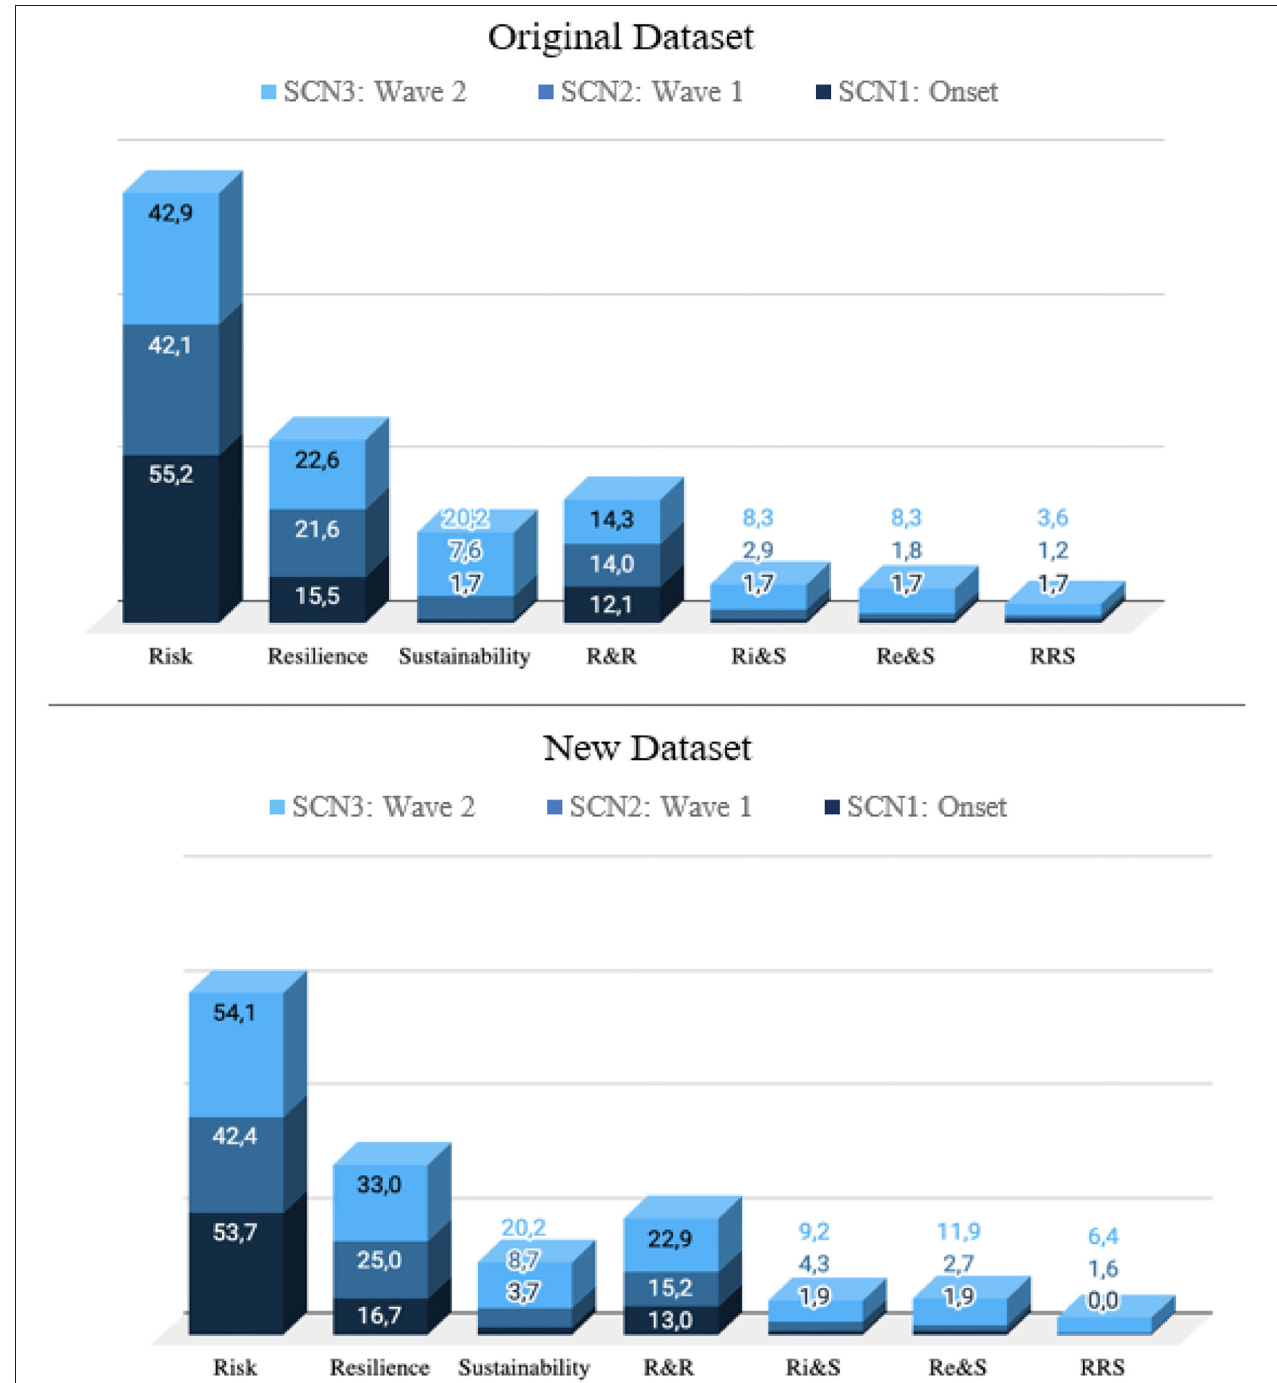
FIGURE 12 | Distribution RRS per time frame of SCN in % for original (23/01/2020–18/08/2020) and new dataset (23/01/2020–18/09/2020).